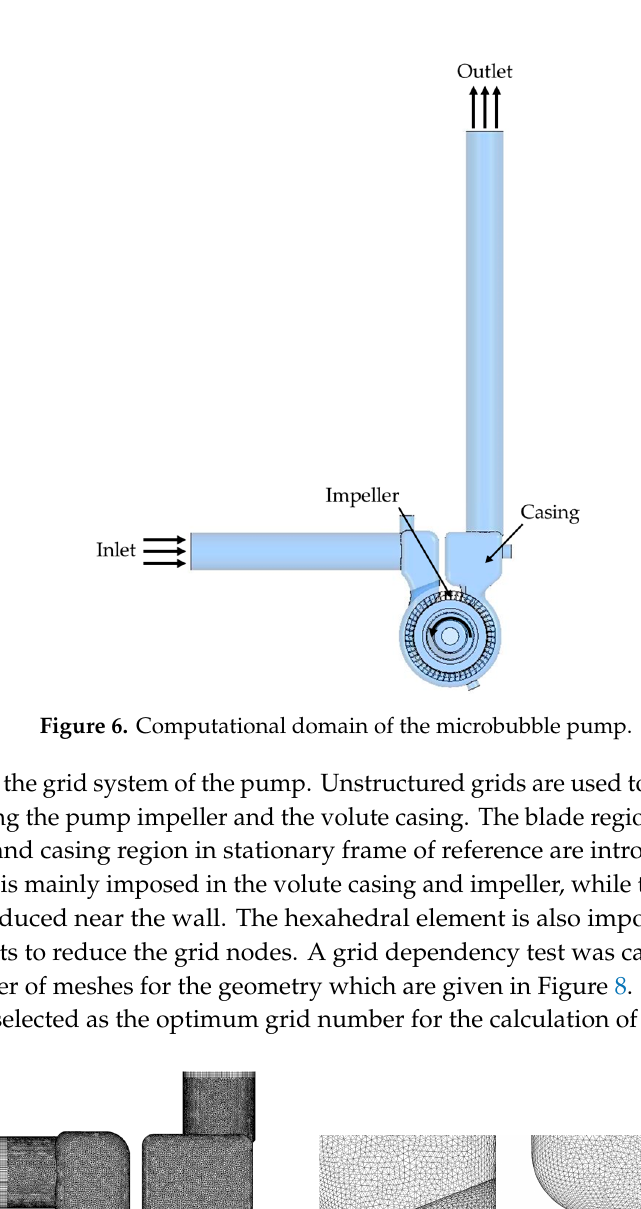
Figure 7. Grid system: ( a ) overall view; ( b ) impeller part.